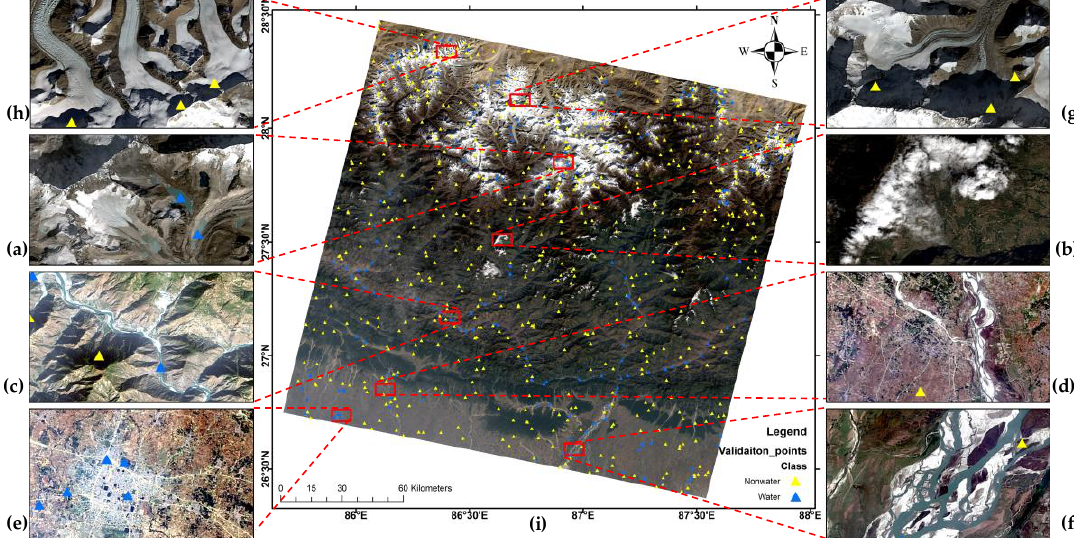
Figure 1. Pansharpened Landsat 8 natural color composite image with water and non-water reference dataset; ( i ) Each red box represents different surface water bodies and noises case in the scene ( a – h ).